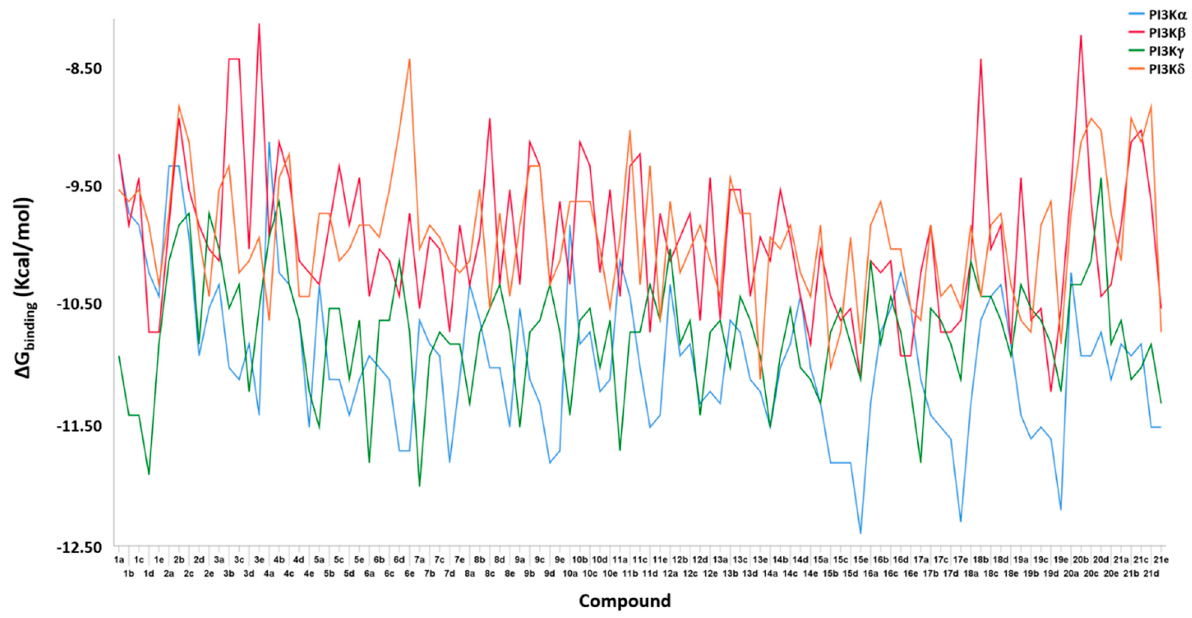
Figure 5. Graphical representation of the binding energies for the designed library of ligands in the 4 isoforms of PI3K. Blue line—PI3K α ; red line—PI3K β ; green line—PI3K γ ; orange line—PI3K δ .